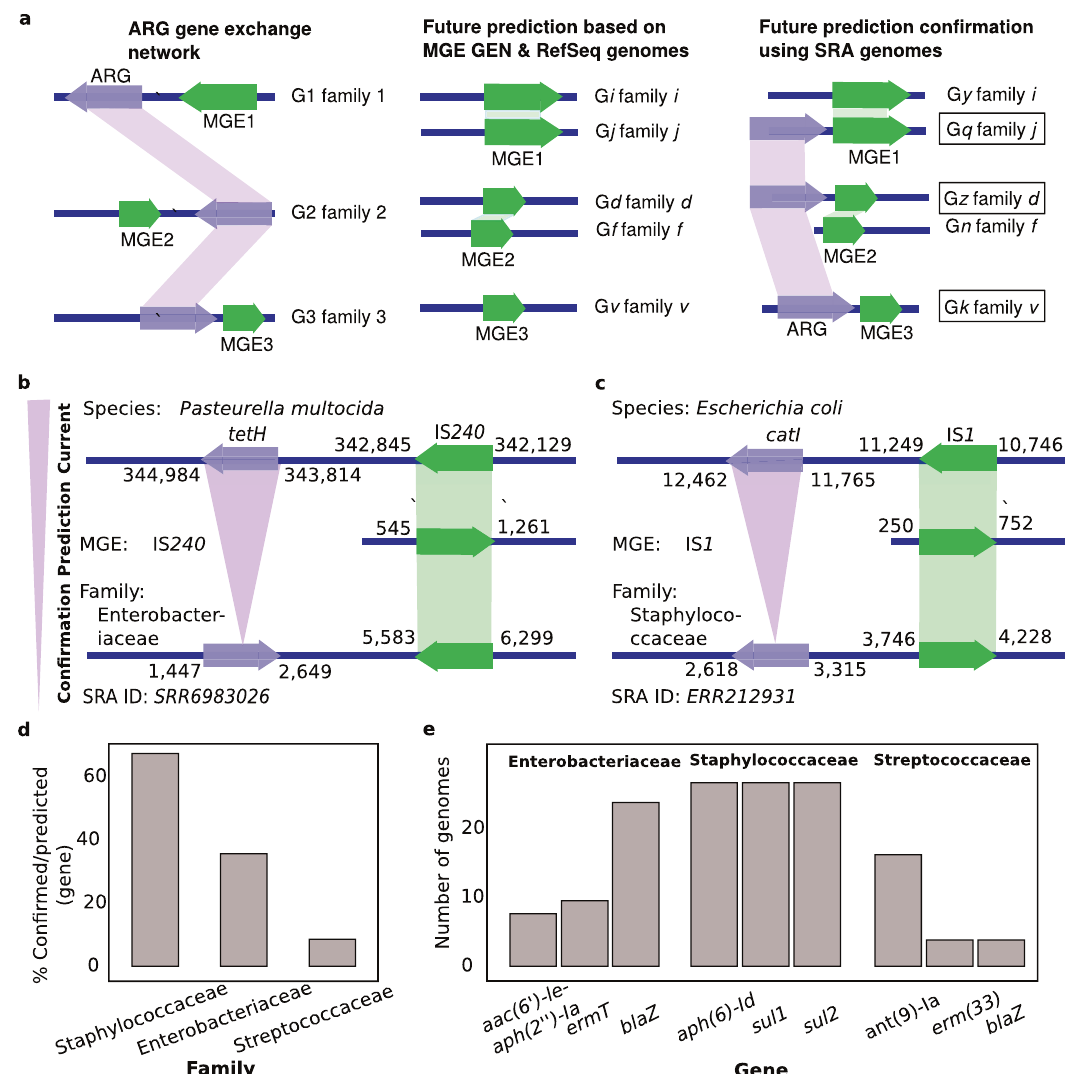
Fig. 5 Computational con fi rmation analyses. a Conceptual guide linking ARGs from gene exchange networks (GENs) to future hosts via their neighbouring MGEs and MGE GENs and con fi rming horizontal gene transfer predictions via SRA genomes. Boxes show con fi rmed transfers of ARGs to predicted hosts. b Example: computational con fi rmation for the tetH gene predicted in Enterobacteriaceae. The gene was observed near IS240 in Pasteurella with IS240 observed in Enterobacteriaceae genome GCF 000693615.1 and con fi rmed in the Enterobacteriaceae National Centre for Biotechnology Information Sequence Read Archive (SRA) genome SRR6983026 . c Example: computational con fi rmation using catI and IS1, observed in Escherichia in the current GEN with IS1 seen in Staphylococcaceae genome GCF 000159555.1 and catI and IS1 found together in Staphylococcaceae SRA genome ERR212931 . d Percents of predicted genes con fi rmed for indicated families. e Top three genes for indicated families that were observed to be in a signi fi cant number of genomes. Source data are provided in Supplementary Data